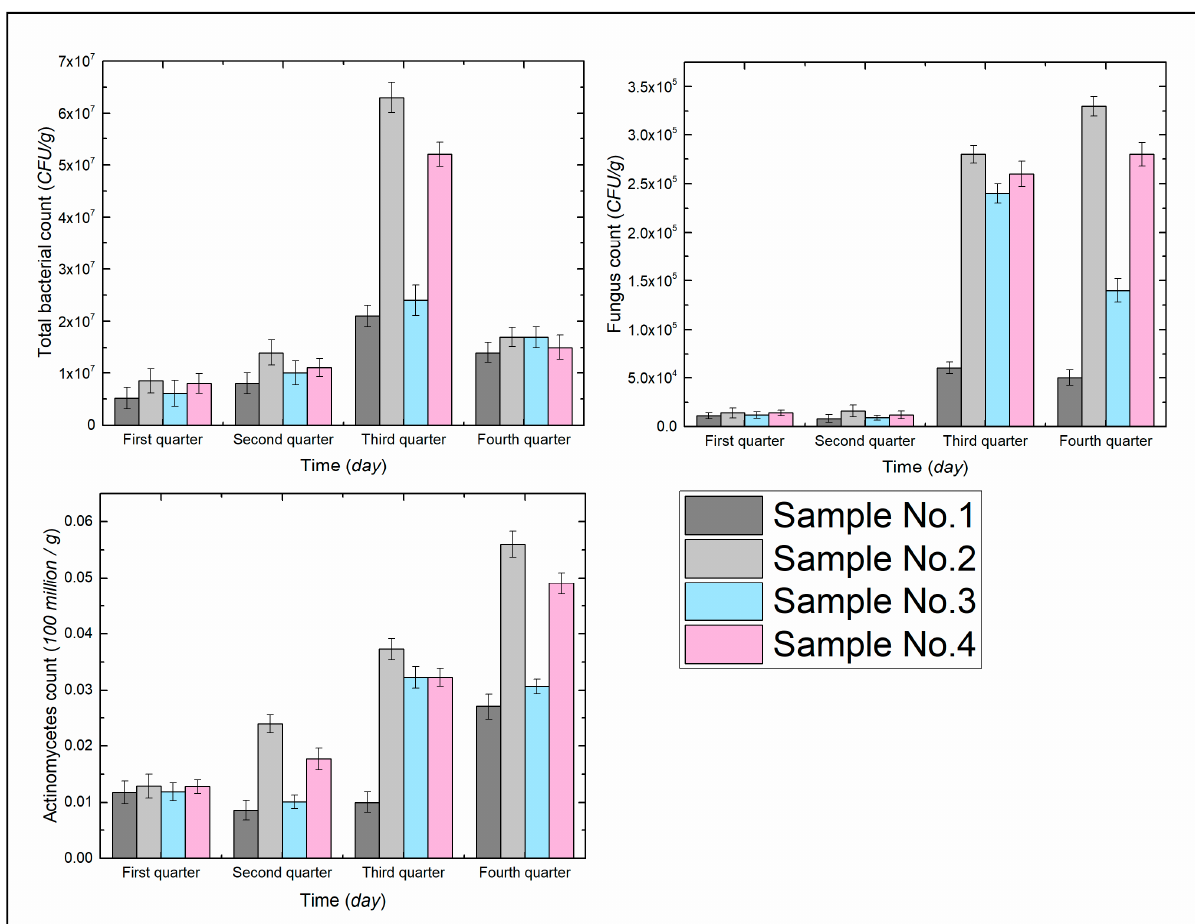
Figure 6. Number of microorganisms in the soil.